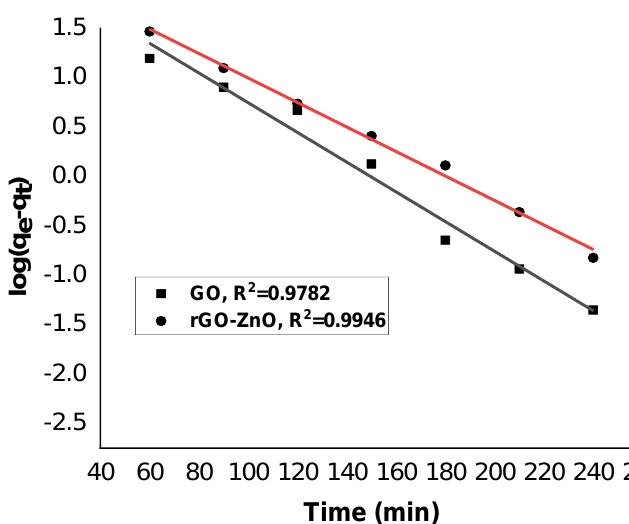
Figure 10. Pseudo-first-order kinetic model for Cr (VI) sorption.